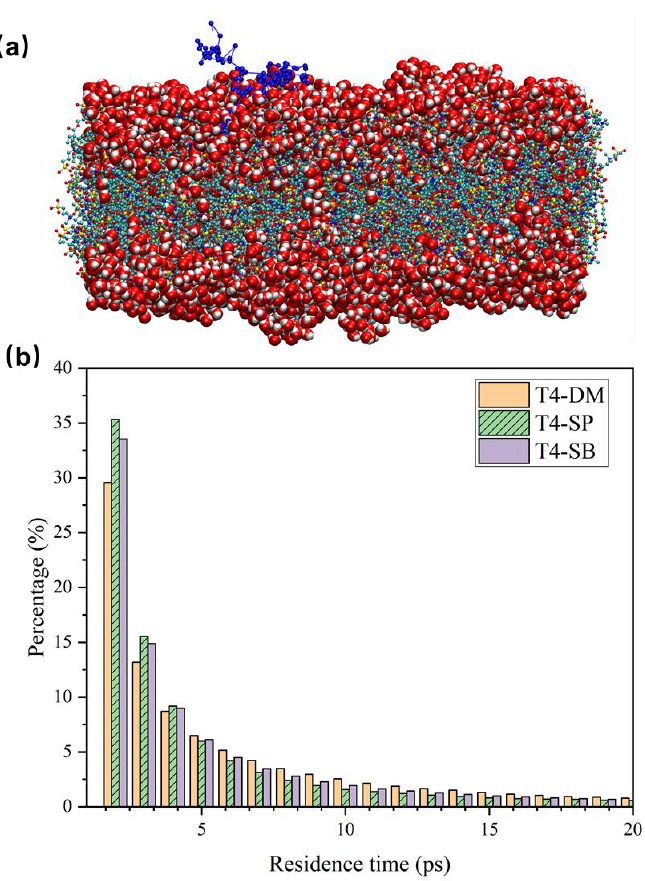
Figure 7. Trajectory and residence time of surface hydration layer water molecules. ( a ) Trajectory of one hydration layer water molecule above T4-SB surface (connected blue dots). The antifouling membrane was colored in CPK mode. The surface hydration layer water molecules were modeled in VDW mode. ( b ) Residence time distribution of water molecules in the hydration layer of three antifouling membranes.